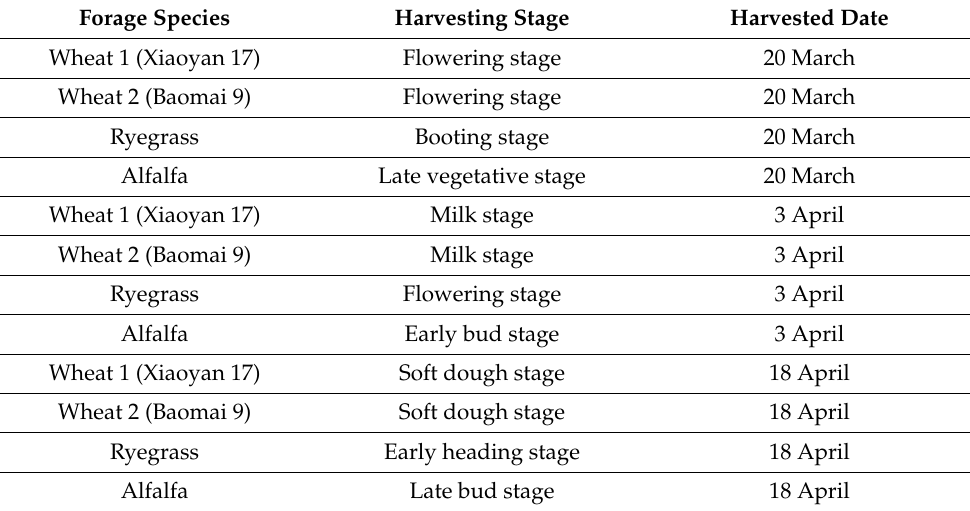
Table 1. Harvesting time and development stages of wheat, ryegrass, and